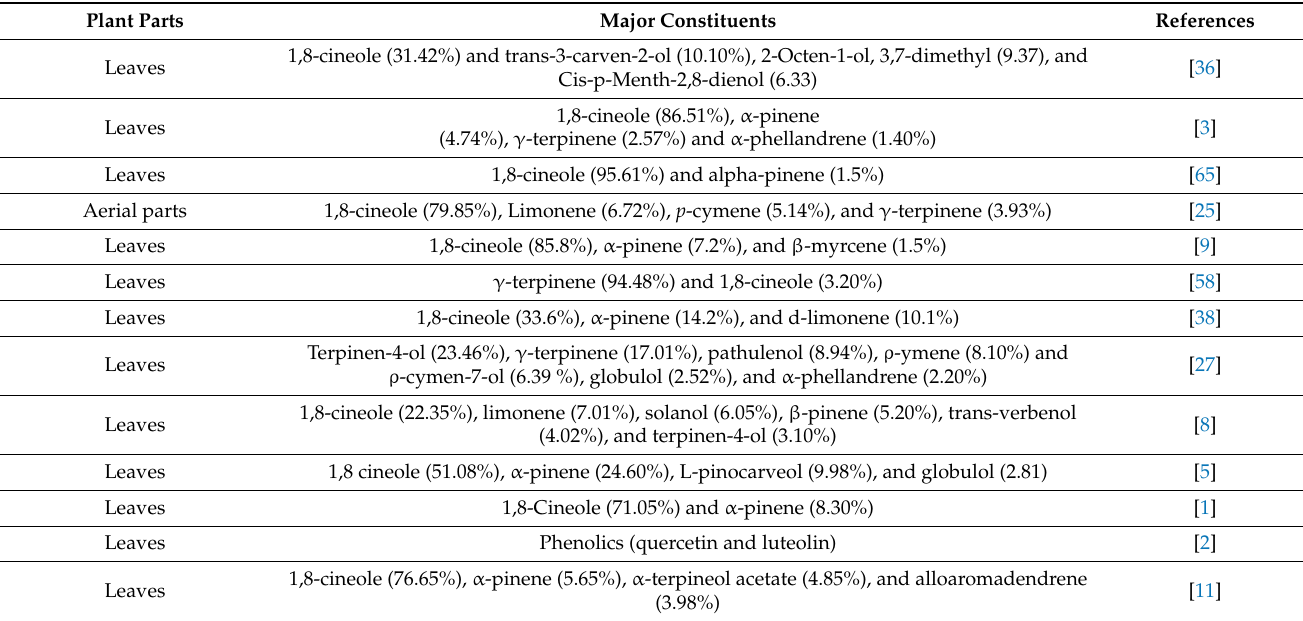
Table 1. Phytochemical compounds reported in the different parts of E. globulus Labill. Plant Parts Major